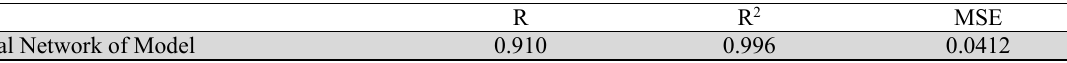
Performance Evaluation of model’s neural